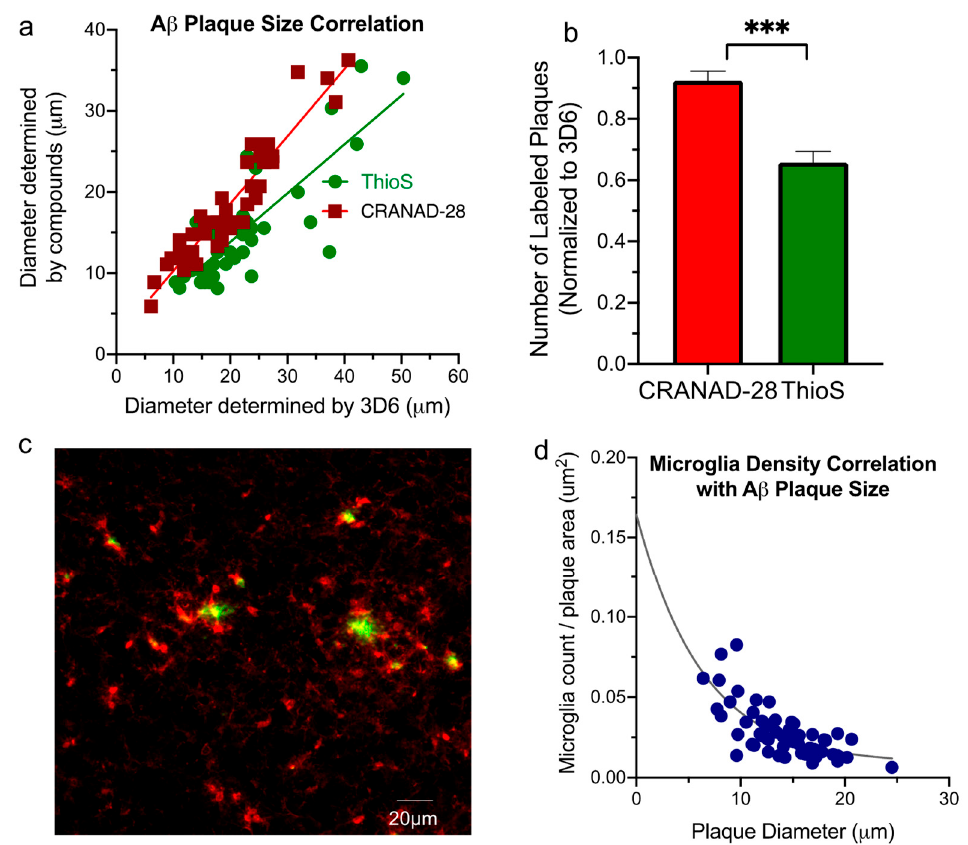
Figure 2. ( a ) Correlations between CRANAD-28 labeling, ThioS and 3D6 antibody staining. It can be seen that in the term of plaque size CRANAD-28 has a better correlation with 3D6; ( b ) consistency count comparation between CRANAD-28 and ThioS. Ratio of stained number of plaques compared as ratios CRANAD-28:3D6 and ThioS:3D6; p value *** < 0.001. ( c ) representative image of plaque staining with CRANAD-28 (green) and microglia staining with IBA-1(red); ( d ) correlation between diameter of plaques labeled with CRANAD-28 and microglia density taken as microglia count divided by plaque area. Rs = − 0.70, p < .001.